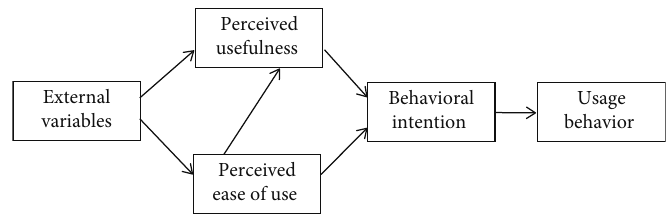
Figure 11: Final version of technology acceptance model (TAM) [34, 35].